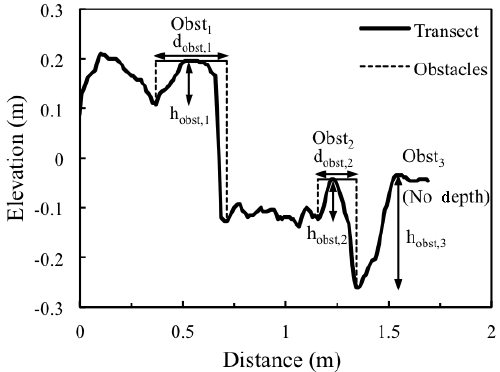
Figure 3. Transect from left to right of Site B showing the identi- fication of obstacles (Obst) and their corresponding heights ( h obst ) and depths ( d obst ) .